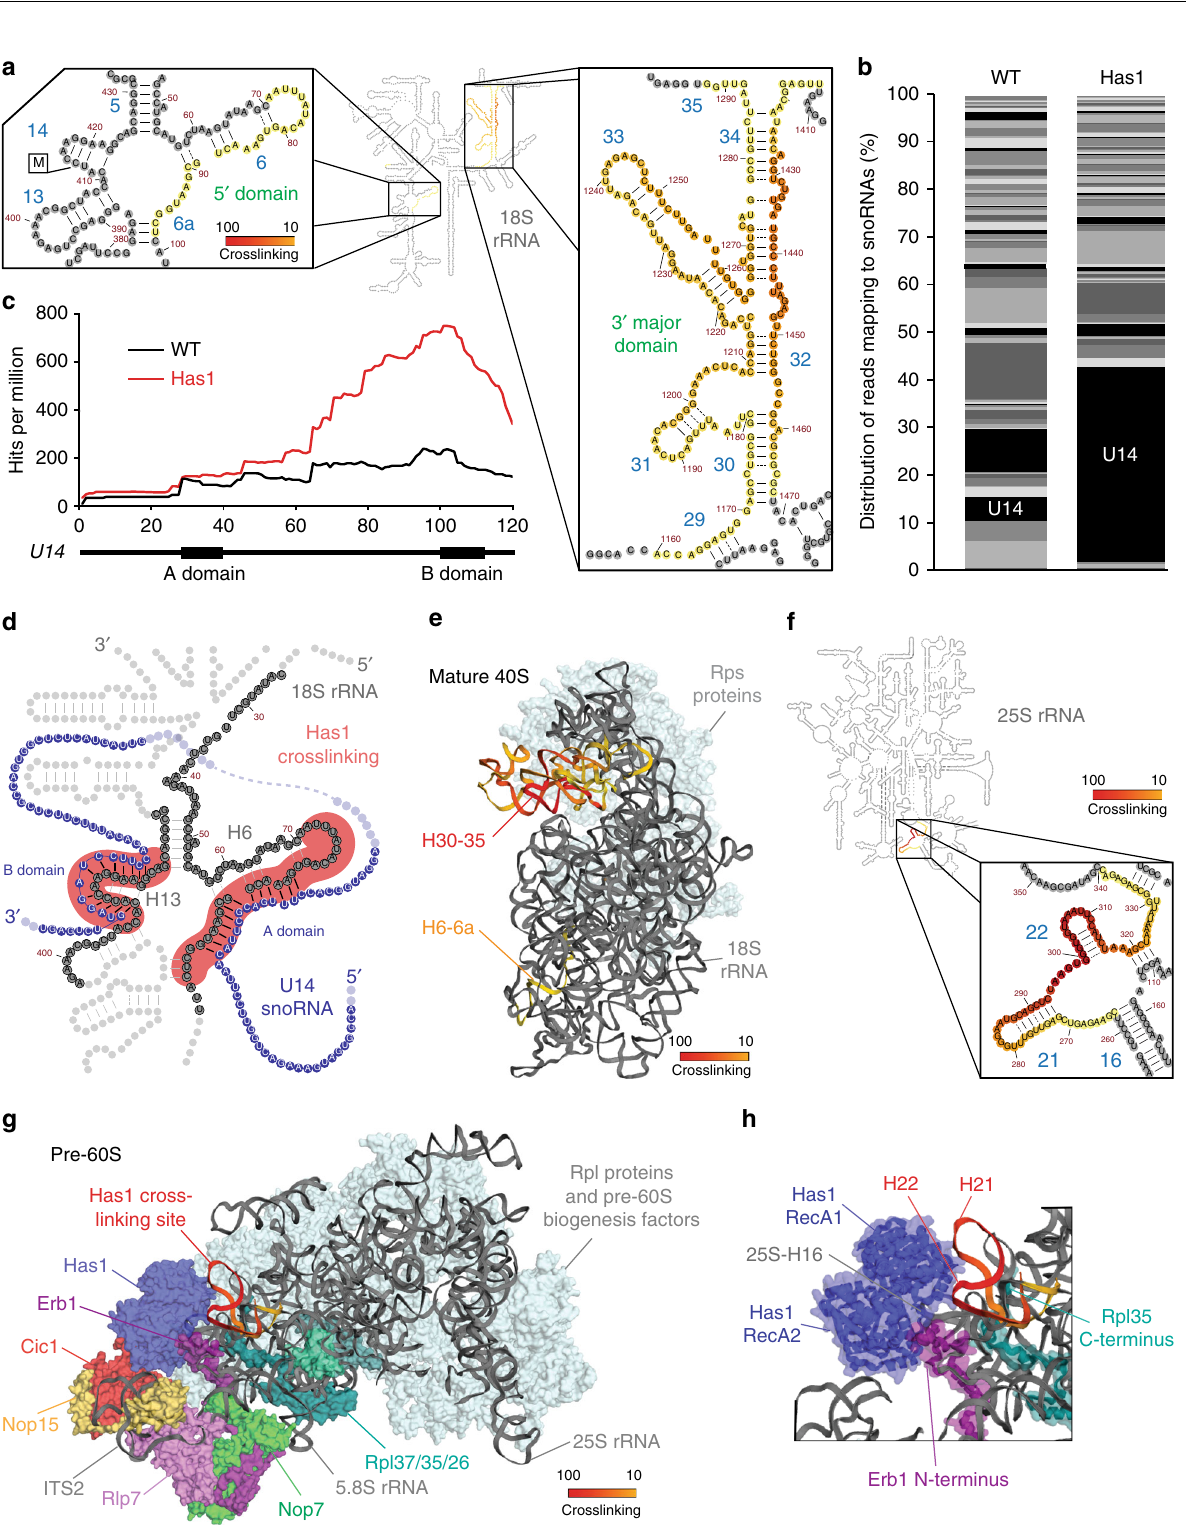
25S rRNA Has1, Mak5 and Spb4 datasets mapping to intergenic regions, or mRNA or tRNA genes, was reduced compared to the control sample, suggesting that these helicases do not act in other aspects of RNA metabolism. Analysis of the distribution of reads map- ping to the rDNA sequence encoding the 35S pre-rRNA tran- script revealed speci fi c crosslinking sites in the 25S rRNA sequence for each of the helicases as well as crosslinking sites of